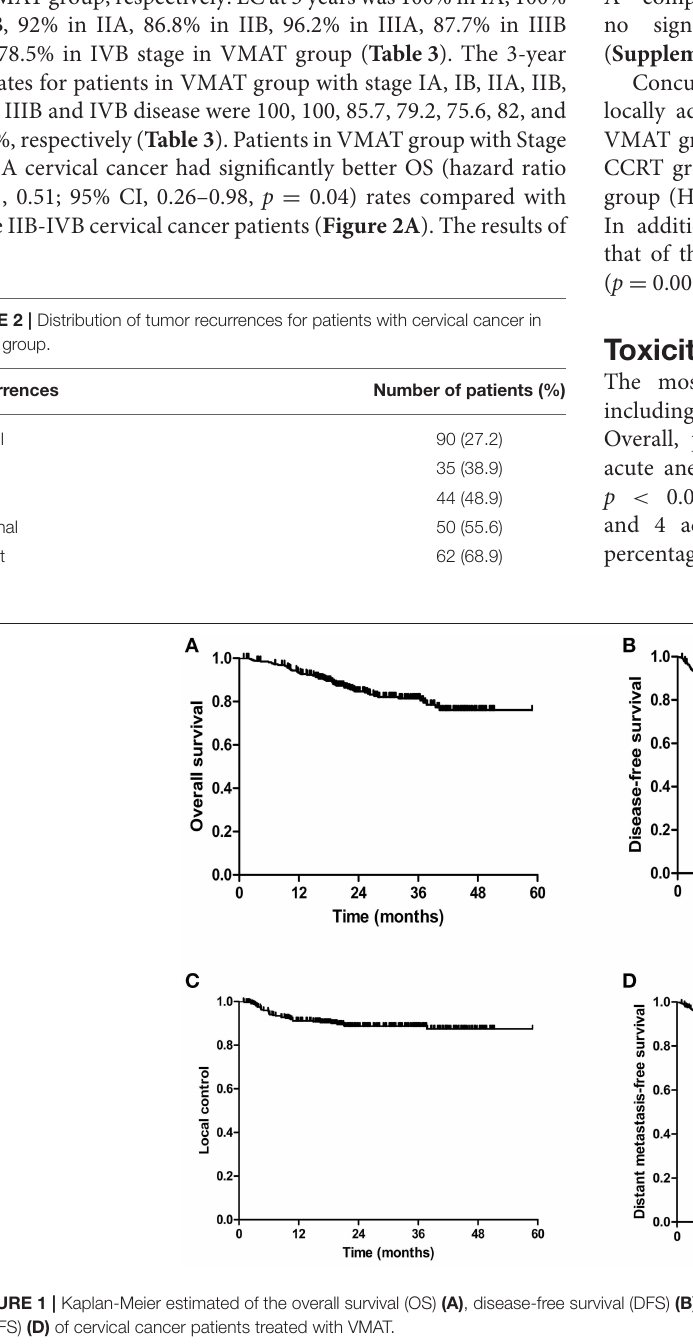
Frontiers in Oncology |